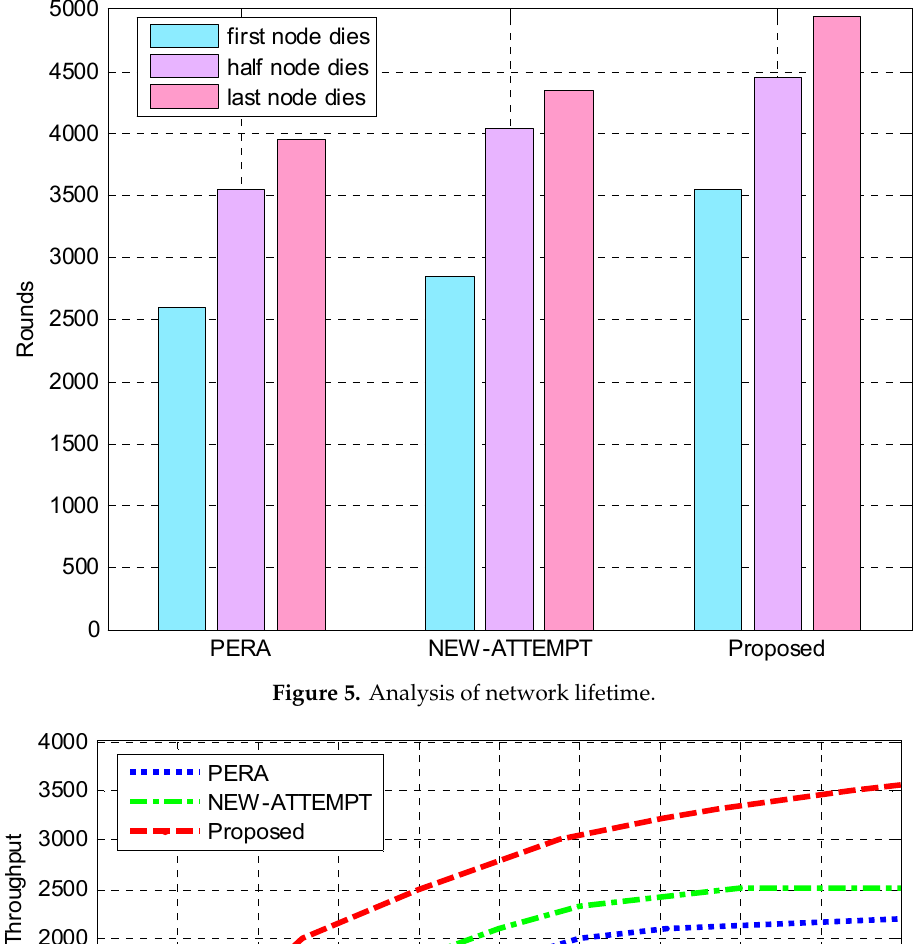
Figure 4. Analysis of network lifetime.